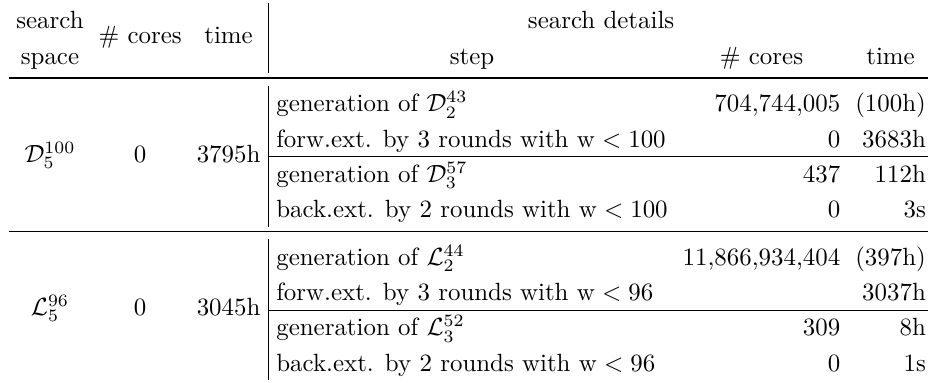
Table 5: Results on the generation of canonical 5-round differential and linear trail cores with weight lower than 100 and 96, respectively. Timings between parentheses mean that we can reuse previous results and they are not counted in the total amount of time.